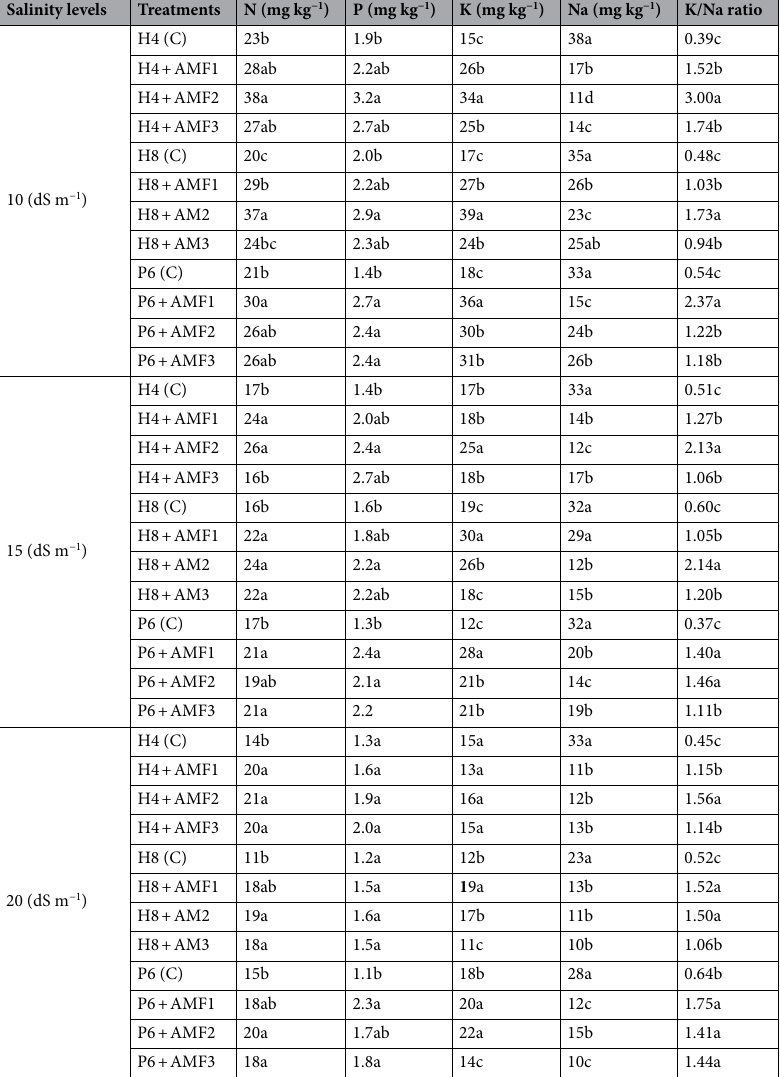
Table 5. Influence of different salinity levels on nitrogen (N), phosphorus (P), potassium (K) and sodium (Na) concentrations and K/Na mass ratio in eucalyptus shoot tissue. AMF1; Glomus sp.2, AMF2; G. albida , AMF3; G. decipiens , and control (C); without pre-inoculation . Values followed by different letters, per salinity level and clone, are significantly different ( P ≤ 0.05) by